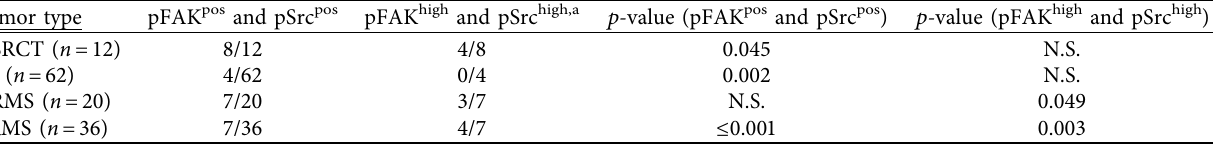
Table 2: Concurrent positive and high-positive pFAK and pSrc expressions in DSRCT, ES, ARMS, and ERMS tumor tissue.